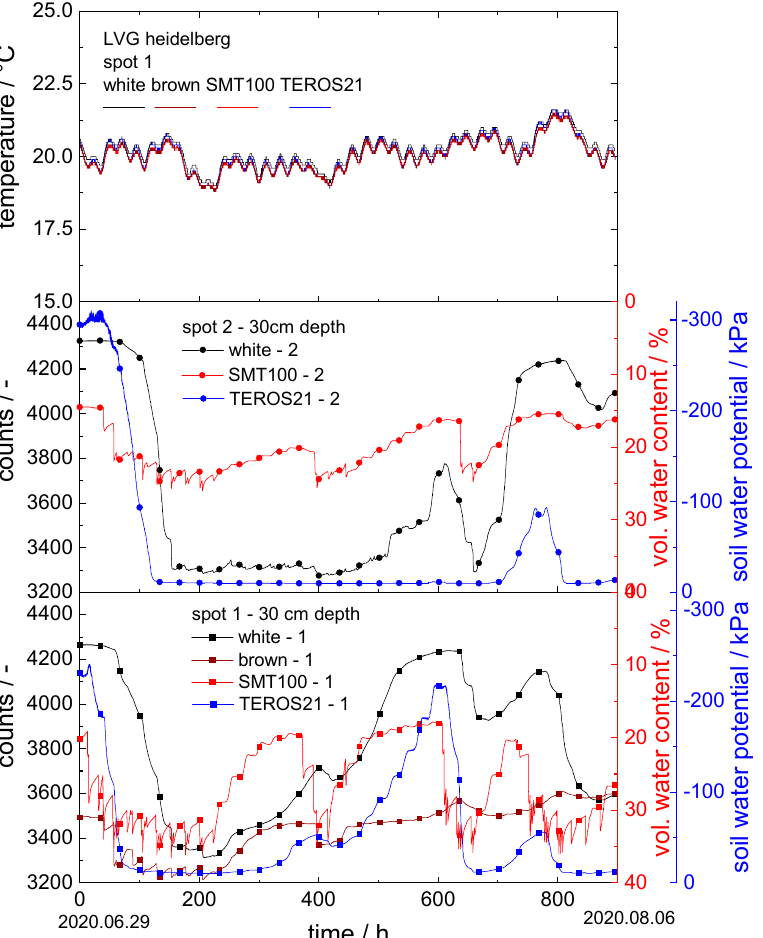
Figure 6. Soil moisture measurement experiment at LVG in tomato research field: the upper graph shows temperature vs. time at all sensor positions; in the middle and lower graphs, counts are plotted vs. time for the new sensors with white and brown ceramic discs; vol. water content vs. time for the SMT100 and soil water potential vs. time for TEROS 21.